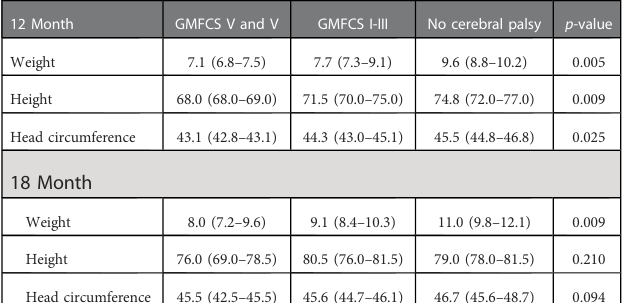
TABLE 3 Weight, height and head circumferences measurements between different cerebral palsy groups, compared with Kruskal Wallis test. 12